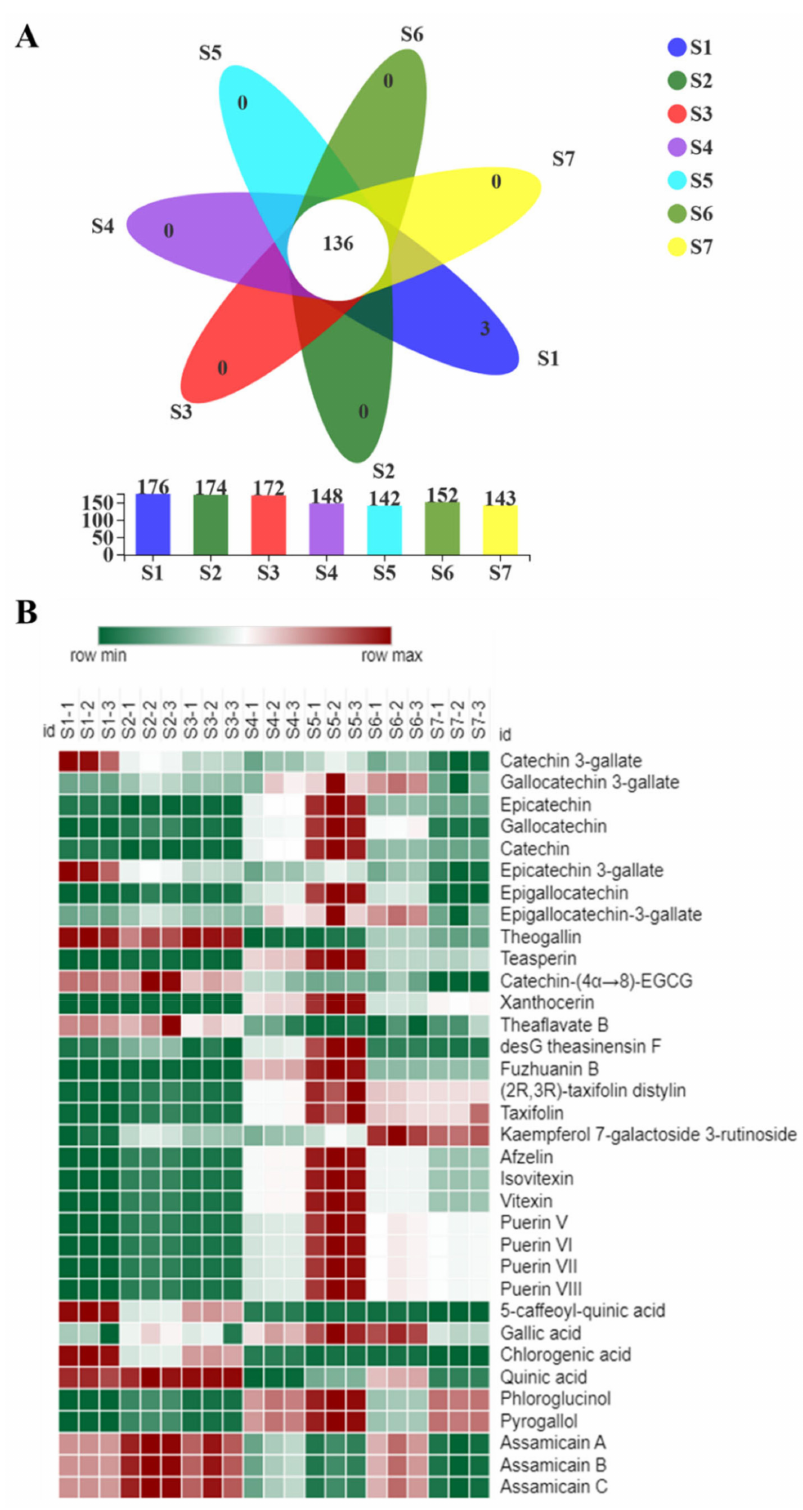
Figure 4. Metabolomics analysis of Fu brick tea samples during processing and storage. ( A ) Venn diagram plot. Numbers represent the identified metabolites. ( B ) Heat map analysis of critical metabolites in different samples. Each column represents a tea sample, and each row represents a critical metabolite. A color-coded scale grading from green to red corresponds to the content of critical metabolite shifting from low to